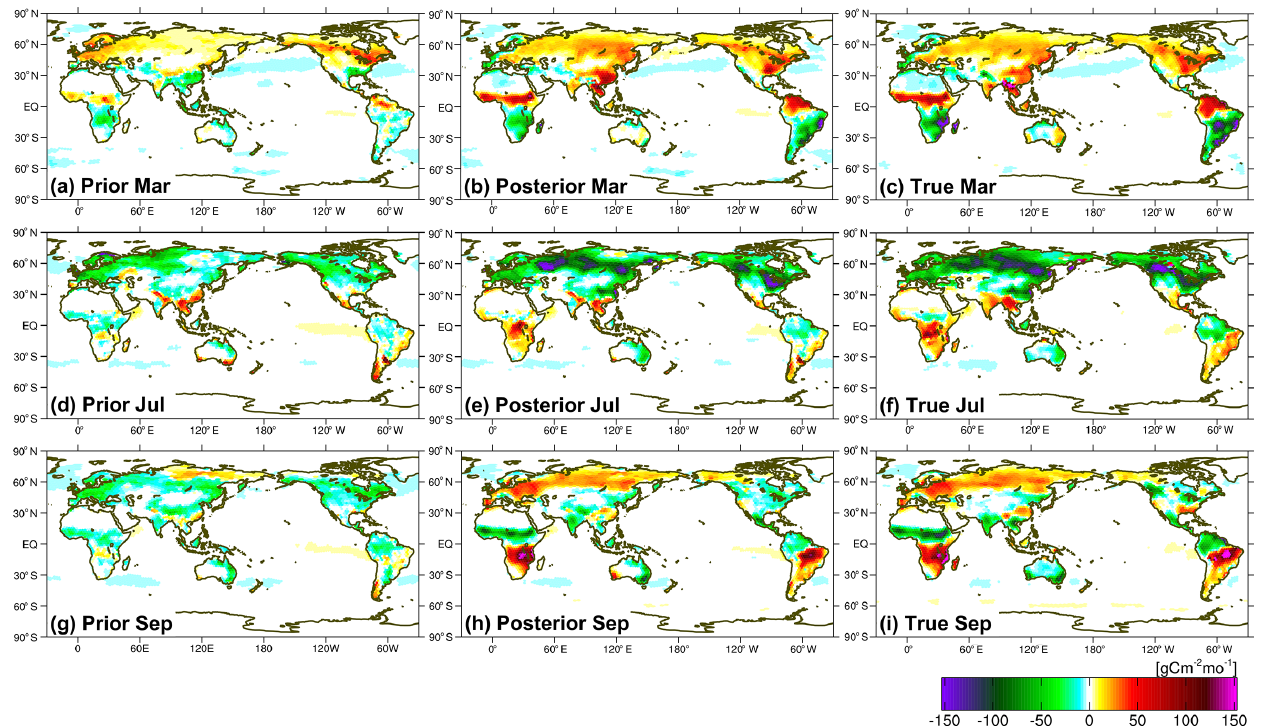
Figure 7. Monthly mean distributions of the prior (left), posterior (middle), and true (right) CO 2 fluxes. Fluxes are shown for March (a–c) , July (d–f) , and September (g–i) of 2010. Note that the fluxes do not include fossil fuel emissions, which are not optimized in the